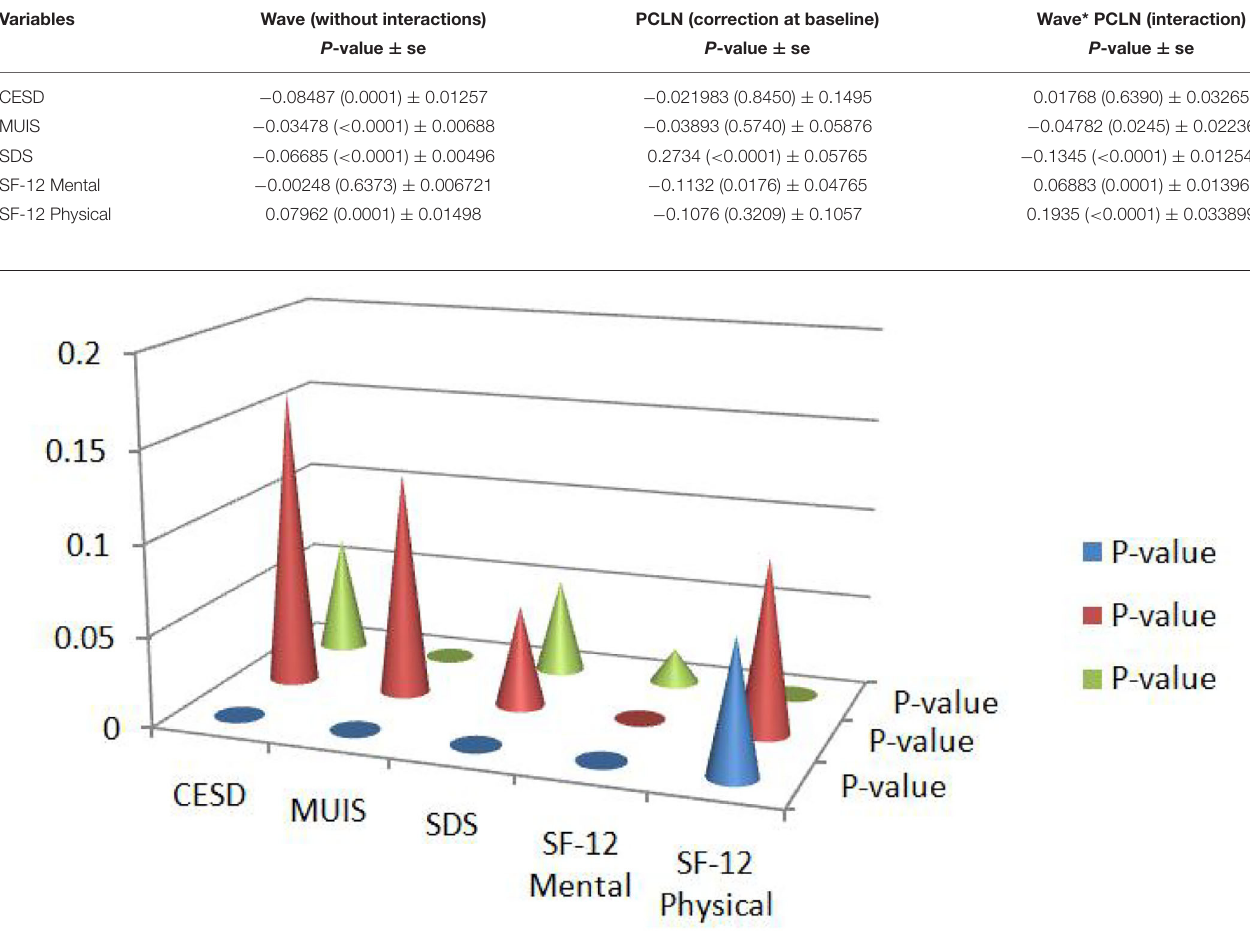
TABLE 6 | Final mixed-effect regression models with identified variables.